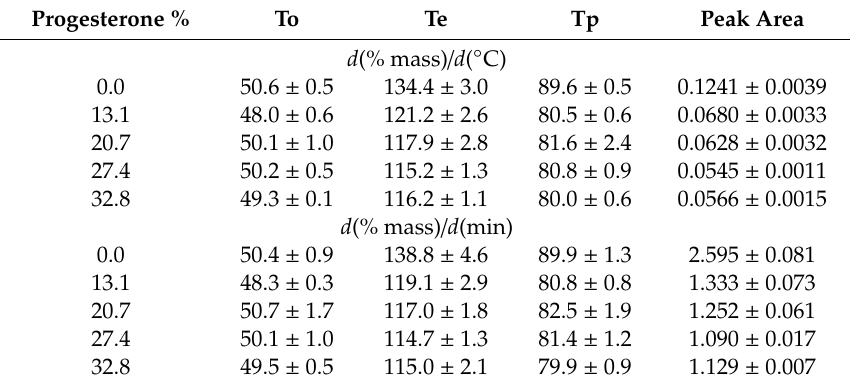
Table 2. Effect of progesterone payload upon the onset, end, and maximum temperatures of ethyl formate peak, as well as its peak area.